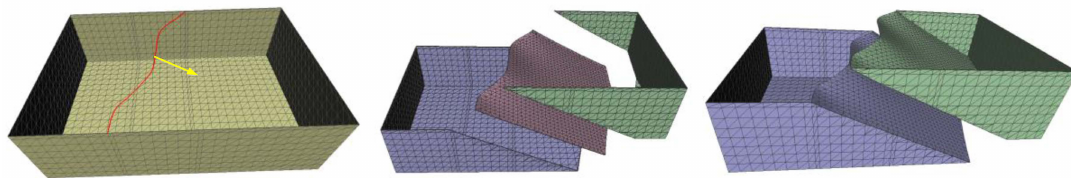
Figure 4. Geological interface created by the geological boundary through HRBF and the fundamental body divided by the geological